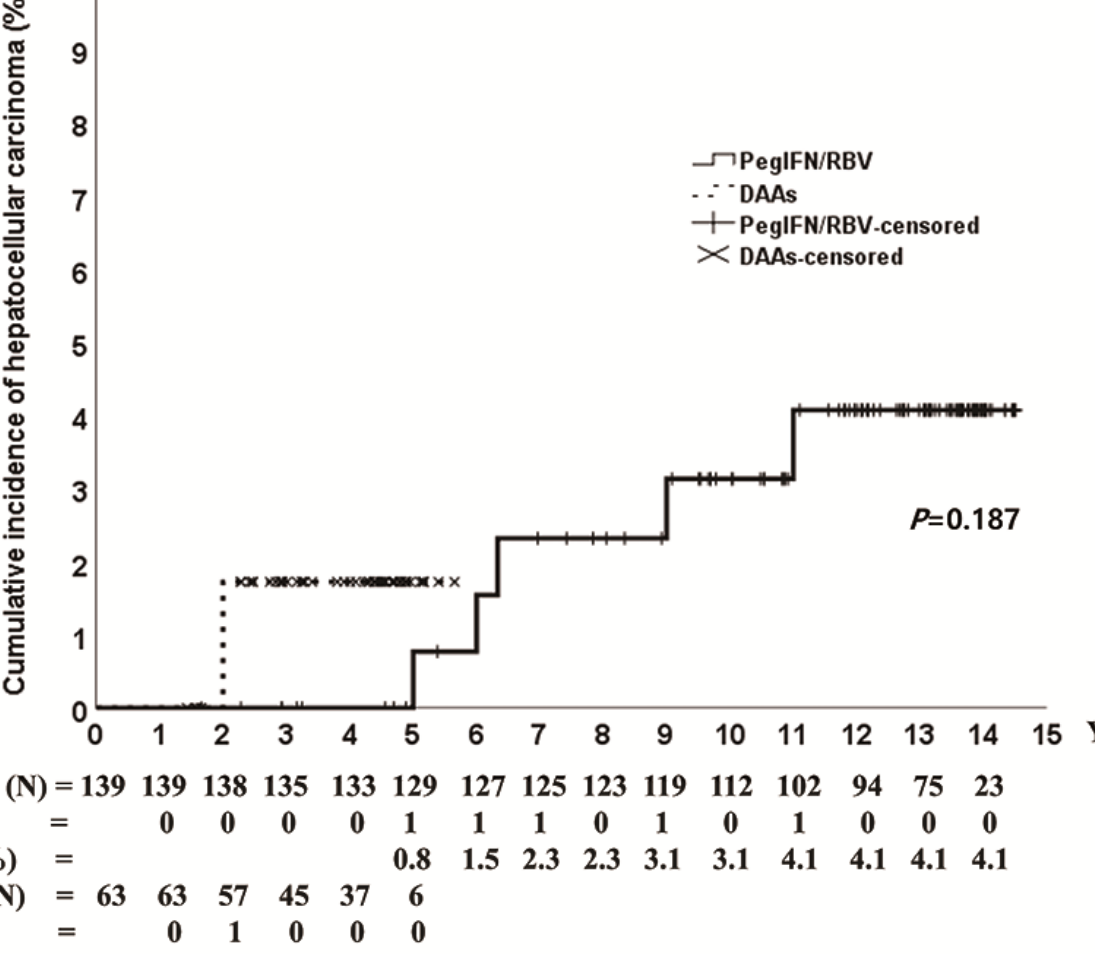
Figure 2. Treatment responses to pegylated interferon plus ribavirin and direct-acting antivirals. PegIFN/RBV, pegylated interferon plus ribavirin; DAAs, direct-acting antivirals.